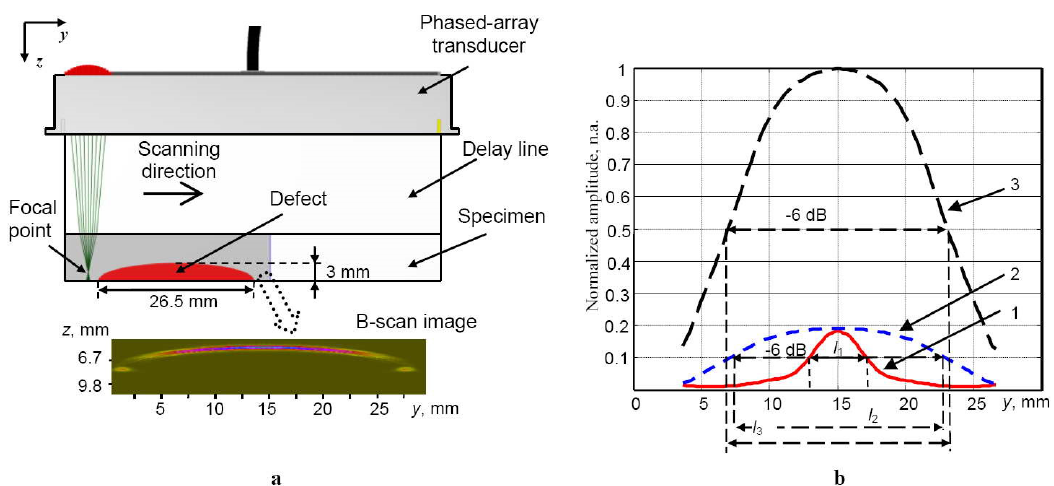
Figure 7. Simulations of the ultrasonic B-scan image obtained by the ULPAT with the delay line (material Plexiglas) within the specimen under investigation in the case of the linear electronic scanning along the axis y (azimuth cross-section) performed using CIVA (Simulation Software for Non-Destructive Testing) software ( a ) and the peak values of the reflections from the defect ( b ): 1—in the case without focusing, 2—focusing the ULPAT in the active aperture (azimuth cross-section) only, 3—dual focusing in the elevation and azimuth cross-sections.